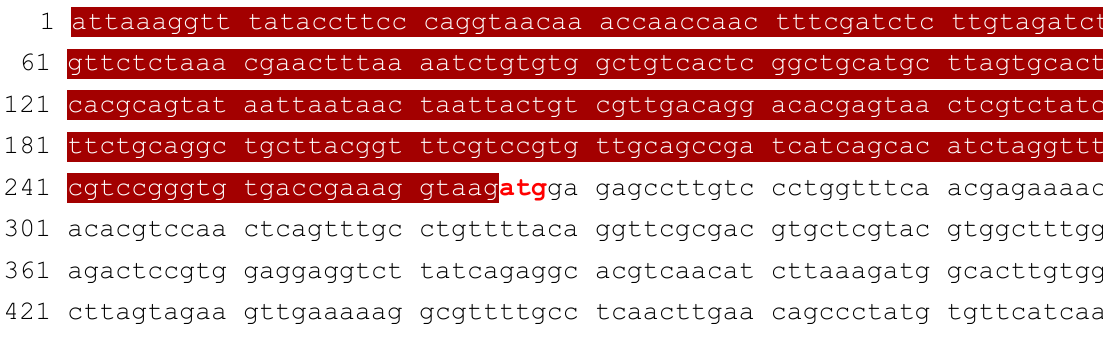
5’UTR 2019-nCoV HKU-SZ-005b (accession number MN975262)